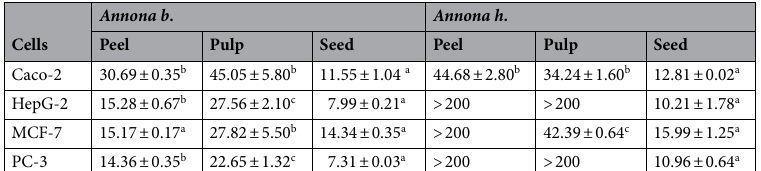
Table 3. IC 50 (µg/ml) of different extracts of Annona b . and Annona h . against proliferation of human cancer cell lines. Results are presented as Mean ± SE (n = 3). Different letters in the same row are significantly different at p < 0.05; IC50, concentration of the studied extracts that caused 50% viability for tested